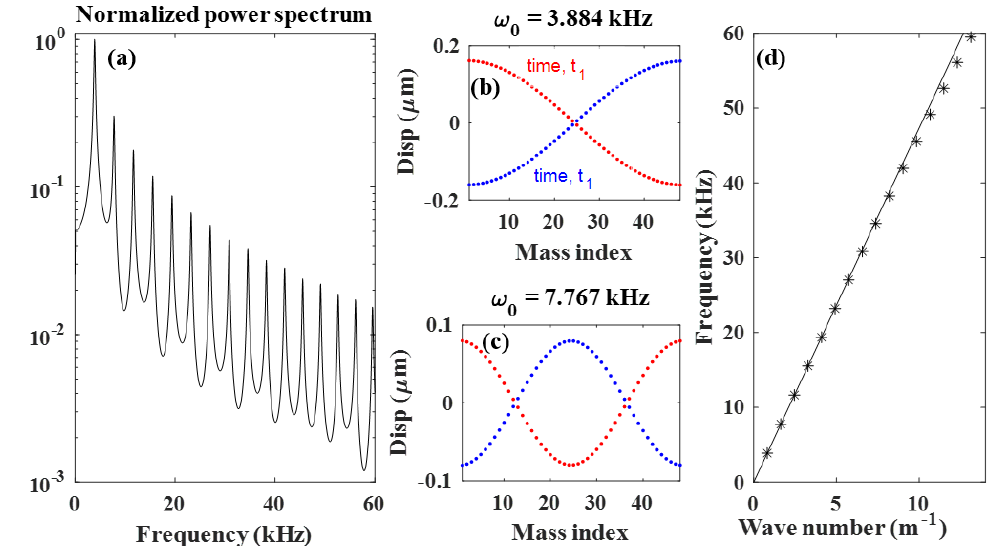
Figure 7. ( a ) Power spectral density of the of the displacement of the N m mass showing the eigen Figure 7. (a) Power spectral density of the of the displacement of the frequencies of the single chain mass-spring waveguides. ( b , c ) Spatial waveforms of the displacements frequencies of the single chain mass-spring waveguides. (b), (c) Spatial waveforms of the of all masses for driving frequency of 3884 kHz and 7767 kHz. Two snapshots of the spatial waveforms displacements of all masses for driving frequency of are shown for time t 1 and t 2 . ( d ) Band structure determined and calculated from ( a – c ). System spatial waveforms are shown for time parameters: N m = 48, η = 6.08 Ns/m, F u ( a )–( c ). System parameters: